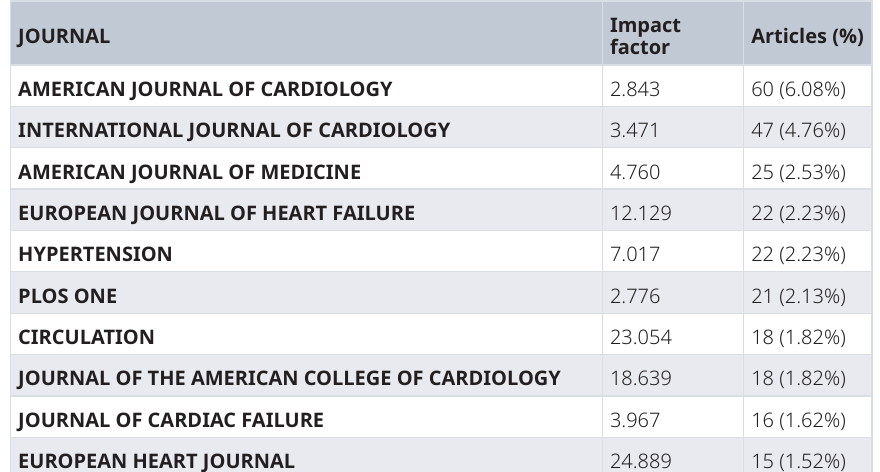
Table 2. Top 10 journals publishing articles that used Biologic Specimen and Data Repository Information Coordinating Center (BioLINCC) open data with their respective impact factor according to 2018 Journal Citation report.